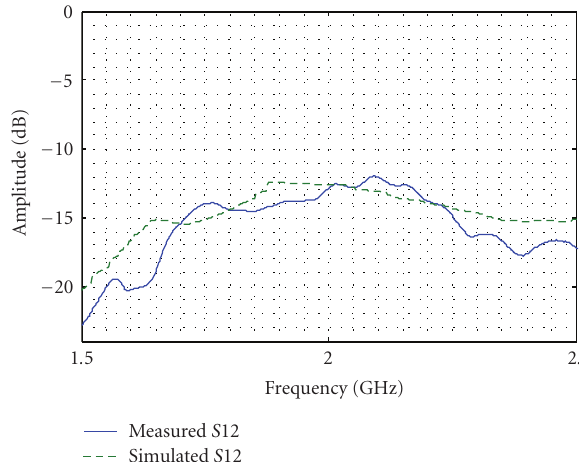
Figure 3: Isolation between the conical and broadside modes.